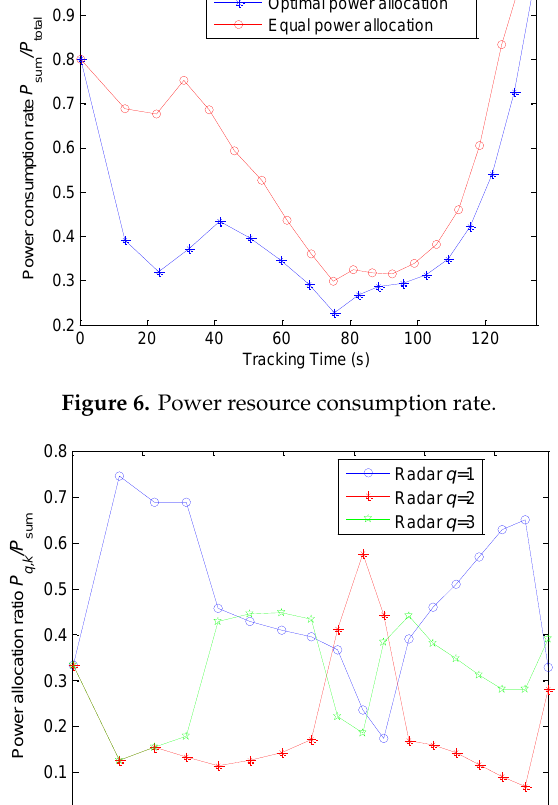
Figure 6. Power resource consumption rate.